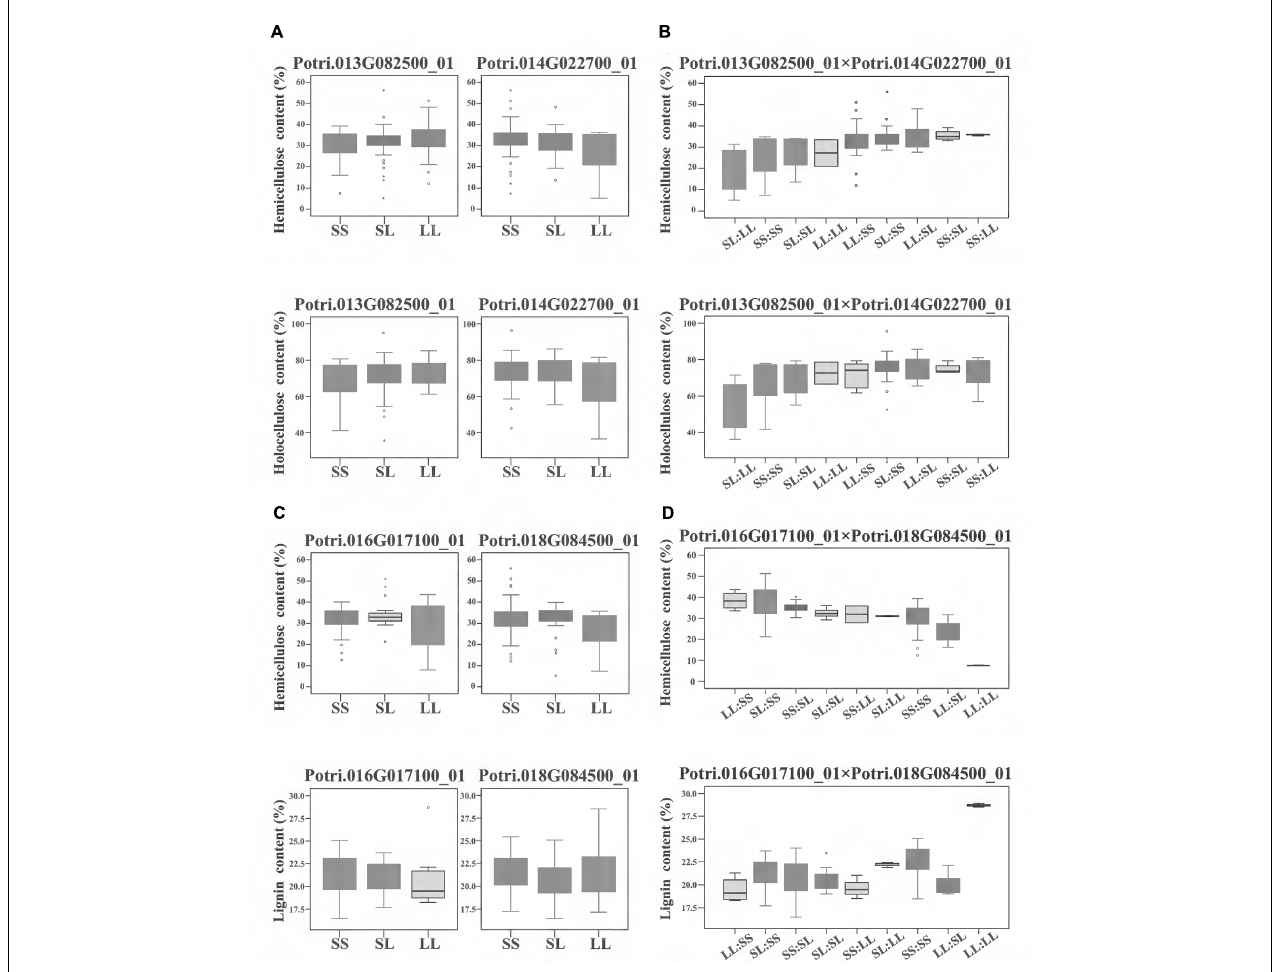
FIGURE 4 | The epistatic interactions of InDel pairs in the P. tomentosa natural population. (A,B) The epistatic interaction between Potri.013G082500_01 and Potri.014G022700_01 showed a negative D × A effect for hemicellulose and holocellulose contents. For hemicellulose contents (upper line), in the absence of epistasis, genotypic effects for Potri.013G082500_01 and Potri.014G022700_01 were almost same. However, with epistasis, their genotypic combination effect (SS:LL) leaded to a considerable increase in hemicellulose contents (an average increase of 18%) and the combination of SL:LL leaded to approximately a 38% decrease in hemicellulose contents. For holocellulose contents (lower line), similar genotypic effects were found for the genotypic combination. (C,D) The epistatic interaction between Potri.016G017100_01 and Potri.018G084500_01 showed an opposite A × A effect on hemicellulose content (upper line) and lignin contents (lower line). In the absence of epistasis, the genotypic effects for Potri.016G017100_01 and Potri.018G084500_01 were almost same. However, with epistasis, the genotypic combination LL:LL led to the highest lignin content as well as the lowest hemicellulose content, and the genotypic effect for hemicellulose content dropped with the increase of lignin content. (A,C) Box plot indicates the additive/dominant effect for each InDel without epistatic effects. (B,D) Box plot indicates the epistatic effects between InDel pairs. D × A and A × A represent dominance × additive and additive × additive interaction. SS, SL, and LL represent deletion/deletion, insertion/deletion, and insertion/insertion,